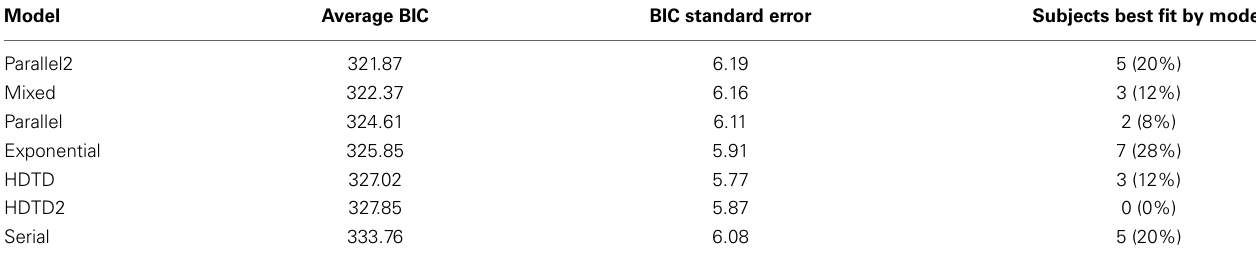
Table 1 | Model fitting